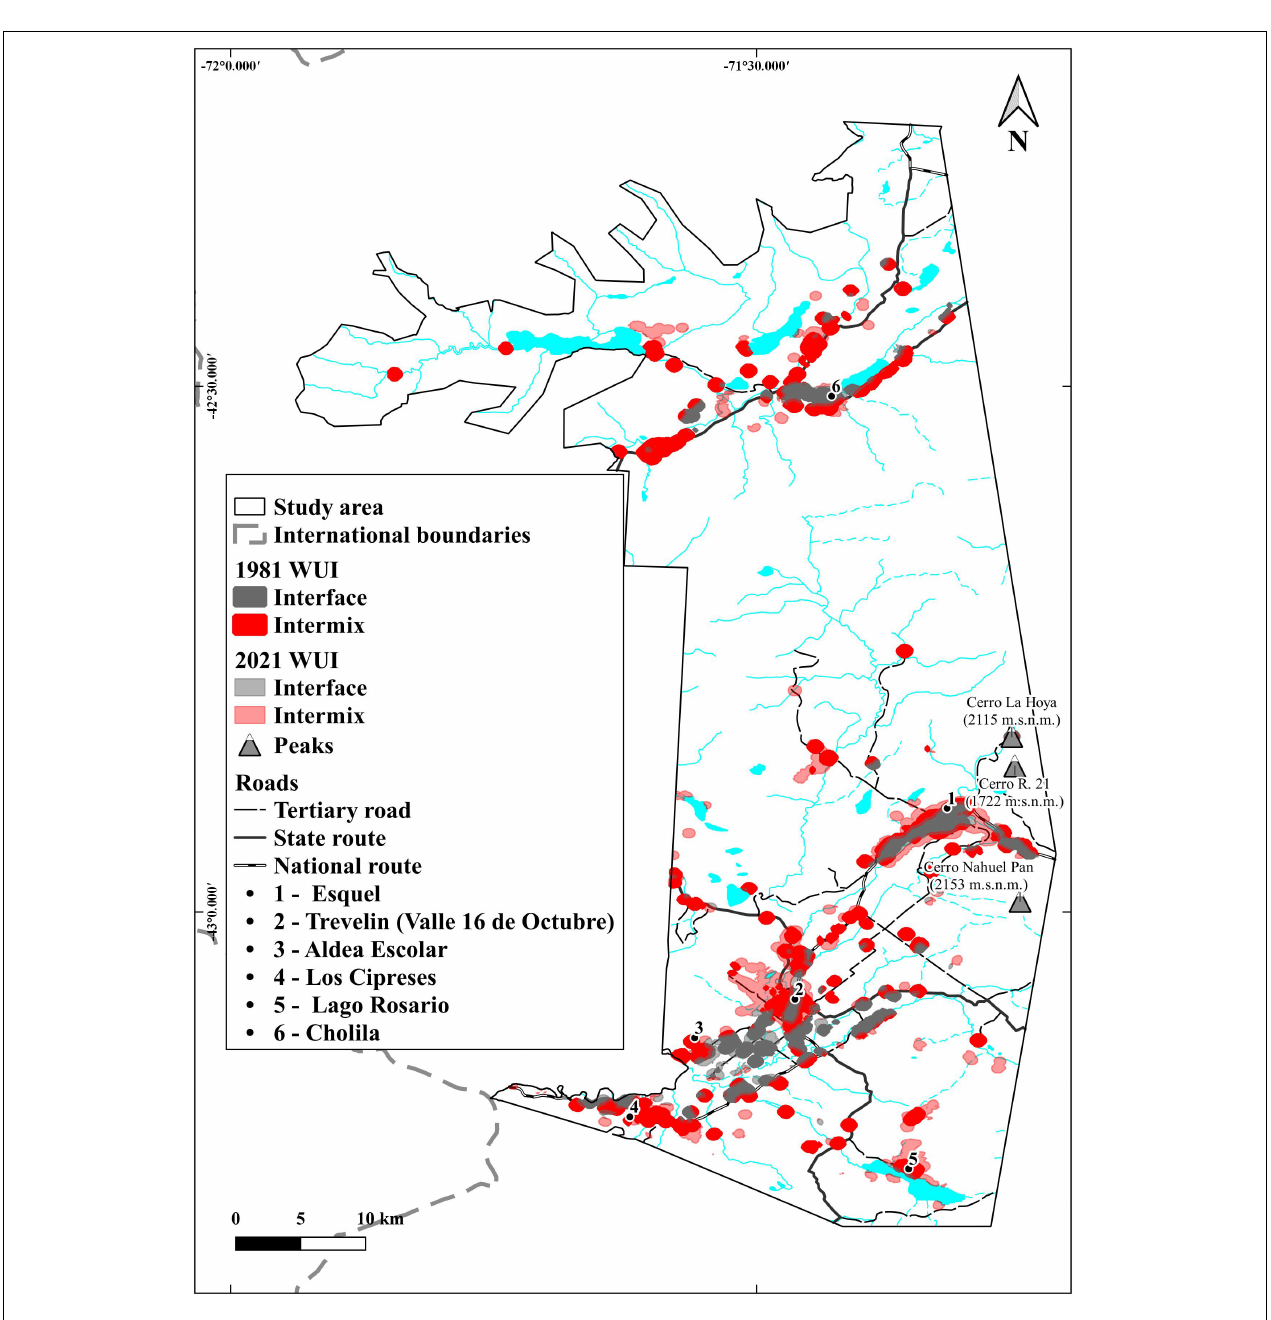
FIGURE 4 | Wildland Urban Interface in the study area. WUI in 1981: the interface zone is in yellow, the intermix zone is red. WUI in 2021: the interface zone is in gray and the intermix zone is in pale red.